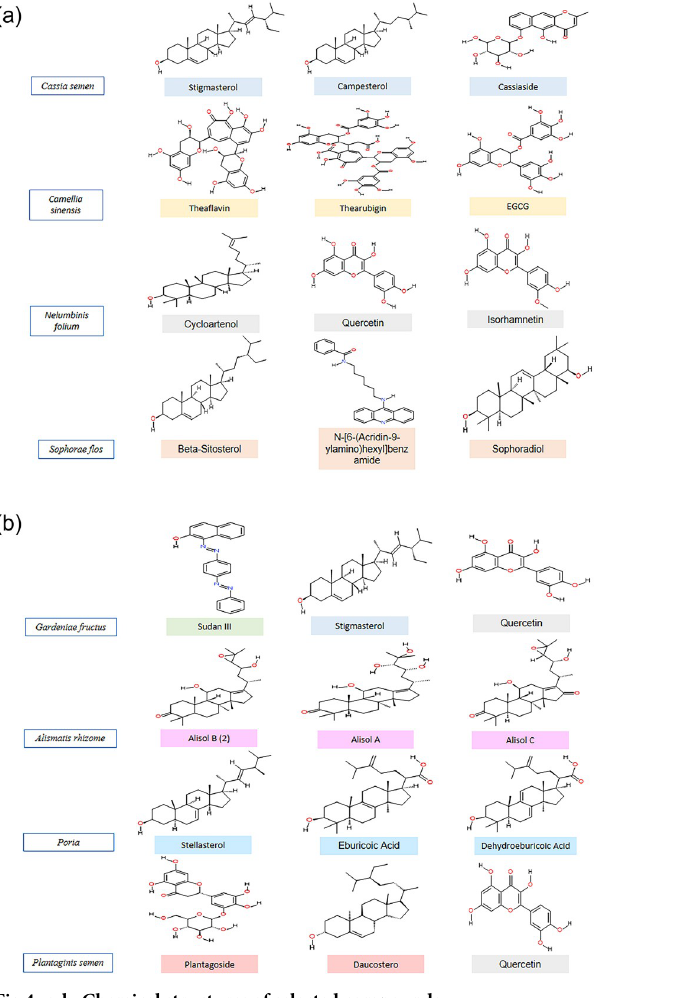
Fig 4. a-b. Chemical structures of selected compounds. According to the results obtained from the molecular docking, compounds 5 , 6 (extracted from Camellia sinensis ) and 20 (obtained from Plantaginis semen ) had more common residues with acarbose than other included ligands (in contrast, despite exhibiting the highest predicted binding affinity, compound 14 exhibited few common interactions with acarbose). Both com- pounds 6 and 20 displayed additional H-bonds for two main classes of interactions. Firstly, H- bonds with acidic residues Asp300 and Glu233 (compound 6 and 20 ). Secondly, H-bonds with basic residues His305 and His201 (compound 6 ) while compound 20 formed H-bonds with basic residues His299 and His201. Compound 5 did present H-bonds with a pair of acidic resi- dues Glu233, Asp300 but only with one basic residue His305. In addition, there was only one aromatic ring-ring interaction with Trp59 for compound 5 . All three compounds had no H- bonds formed with the backbone of Gly residues, which however presented in the positive control acarbose. This may explain the role of RCM-107 and the relevant individual herbs in inhibiting amylase activities and why they are not as potent as acarbose as observed in this study.